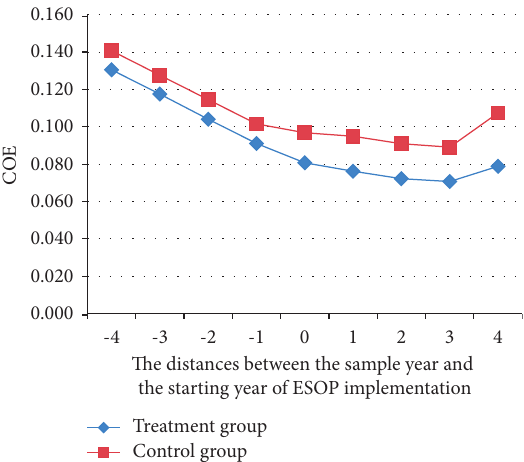
Figure 2: The change trends of equity capital cost in the treatment group and the control group.